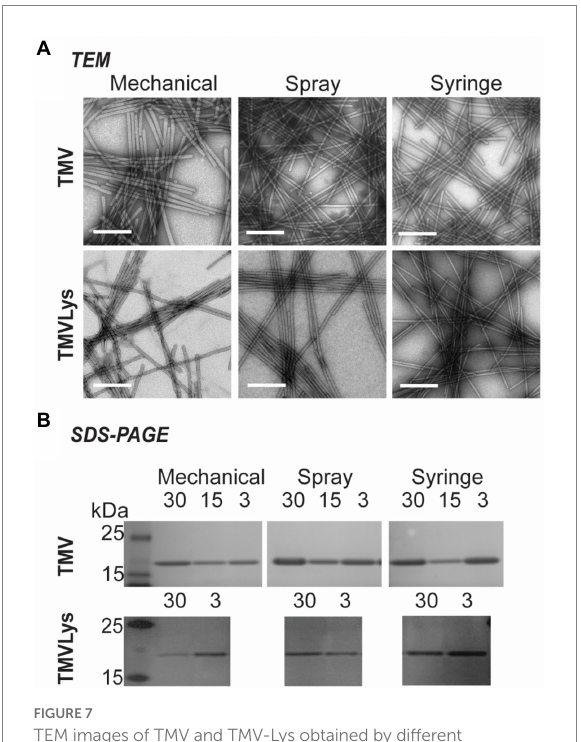
FIGURE 7 TEM images of TMV and TMV-Lys obtained by different inoculation methods, scale bar represents 200 nm (A) . SDS-PAGE of the extracted TMV and TMV-Lys, the presence of its coat protein (17.5 kDa) was consistent in all samples (B)